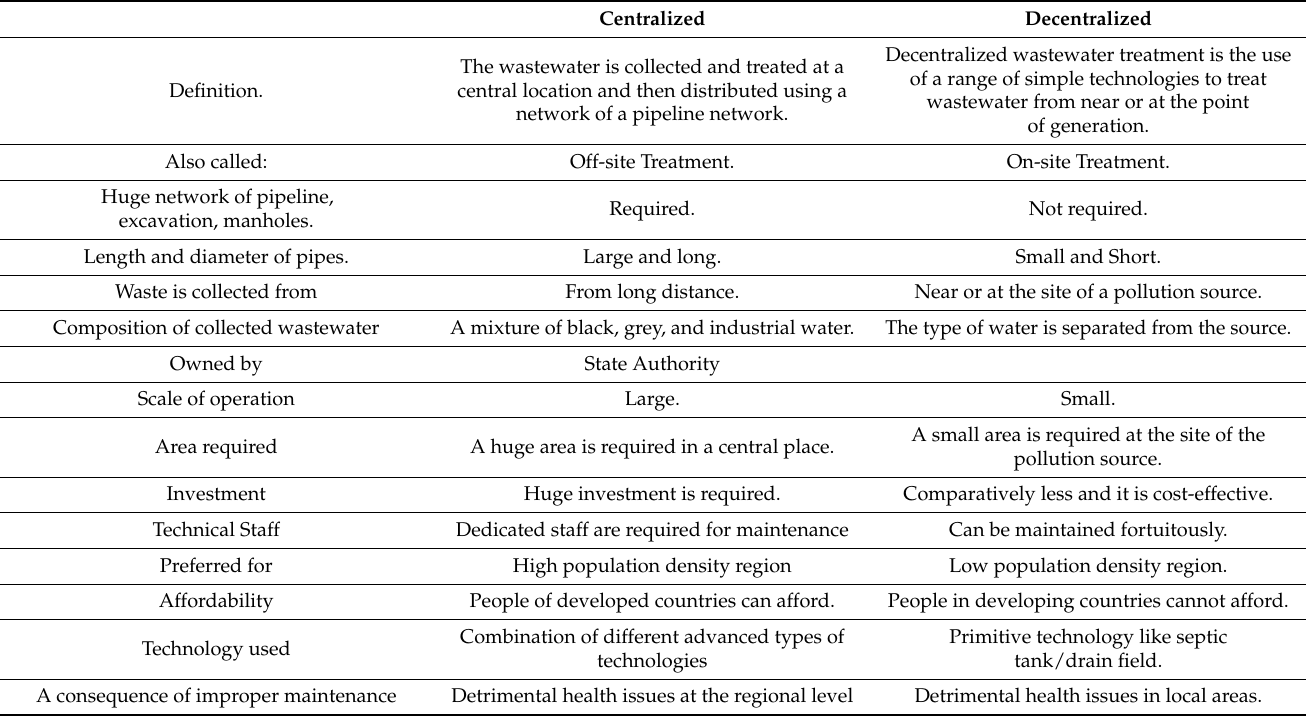
Table 4. Centralized vs. decentralized